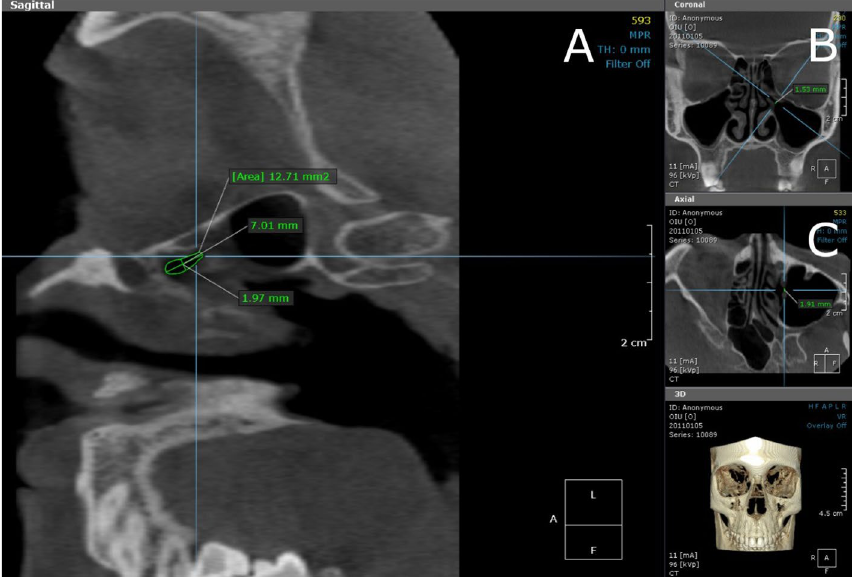
Figure 1. Measured diameters and area from sagittal ( A ), coronal ( B ) and axial ( C ) view. In the sagittal ( A ) and axial ( C ) view, the skull is turned three-dimensionally because the area and the diameter of the ostium is measured perpendicularly to the largest part of the coronal diameter in the coronal view ( B ). Blue lines indicate the direction and the fixing point of the ostium’s section and a white bordered cube indicates the position of the skull and the direction of the image. The letter symbols in the cube signify the following: H = Head view from superior angle, F = Foot view from inferior angle, A = Anterior view from anterior angle, P = Posterior view from posterior angle, L = Left view from left lateral angle and R = Right view from right lateral angle.